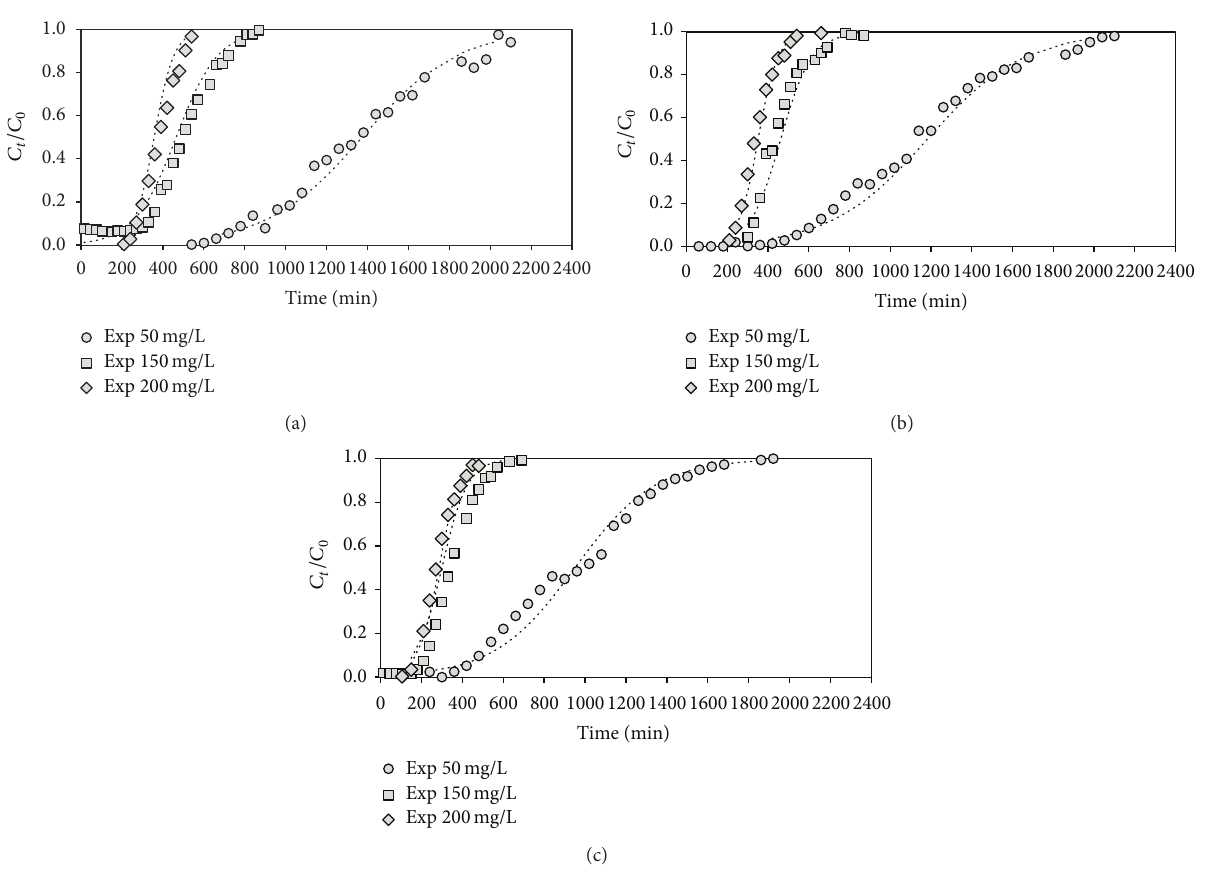
Figure 7: Experimental breakthrough curves at different initial concentration of ternary metal solution of (a) Pb(II), (b) Cu(II), and (c) Ni(II) ( 𝐿 = 2.0 cm; 𝑄 = 0.4 mL/min; model fit is shown as ⋅⋅⋅